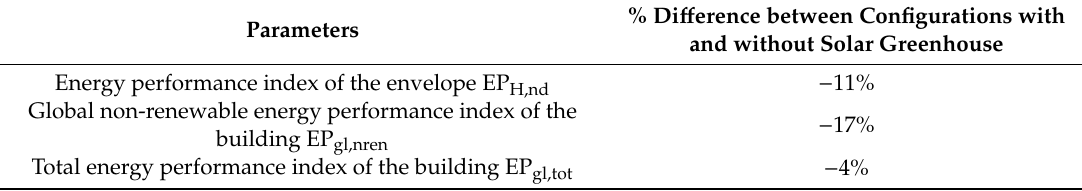
Table 10. Energy performance indices of the configuration with solar greenhouse compared in percentage with those of the variant without solar